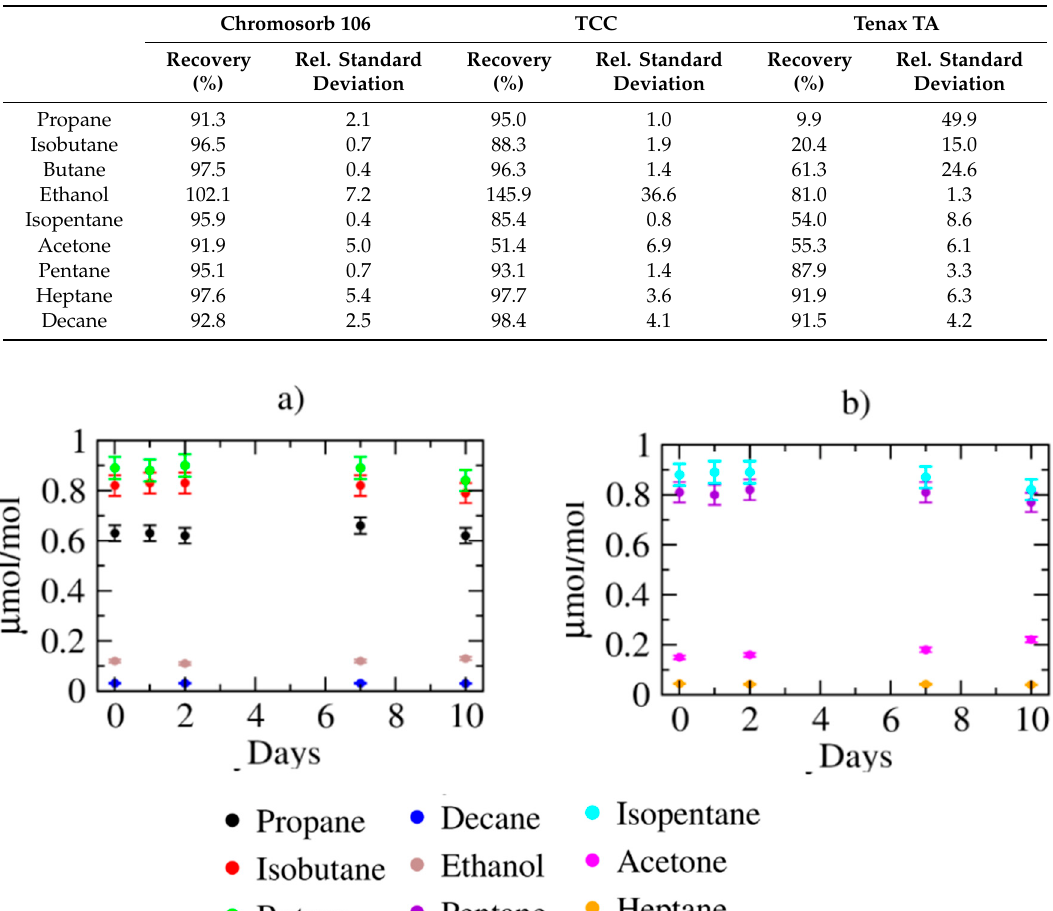
Table 6. Recovery yield obtained for hydrocarbons on 3 di ff erent sorbent tube.